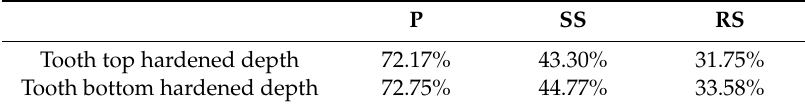
Table 7. Correlations between process parameters and hardened depth.